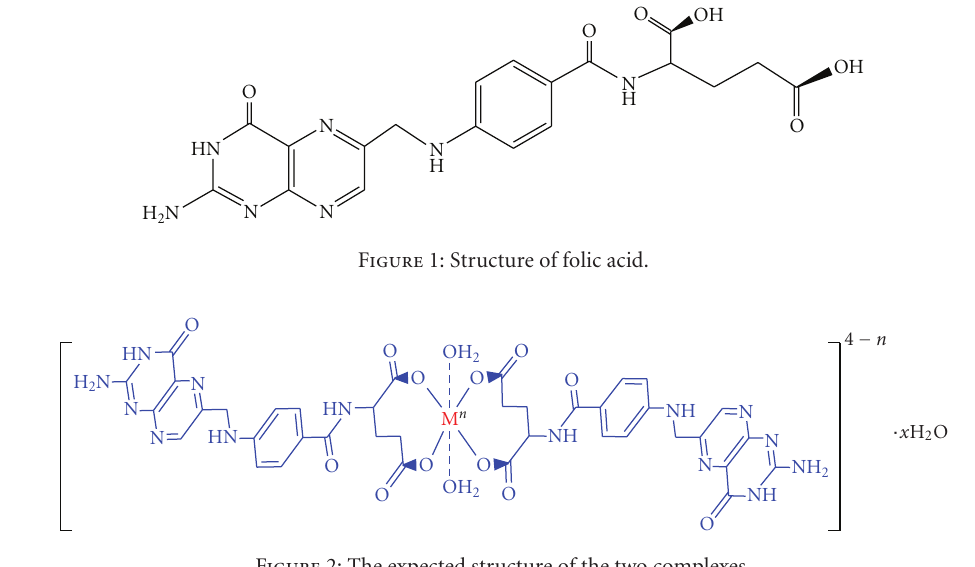
Figure 2: The expected structure of the two complexes